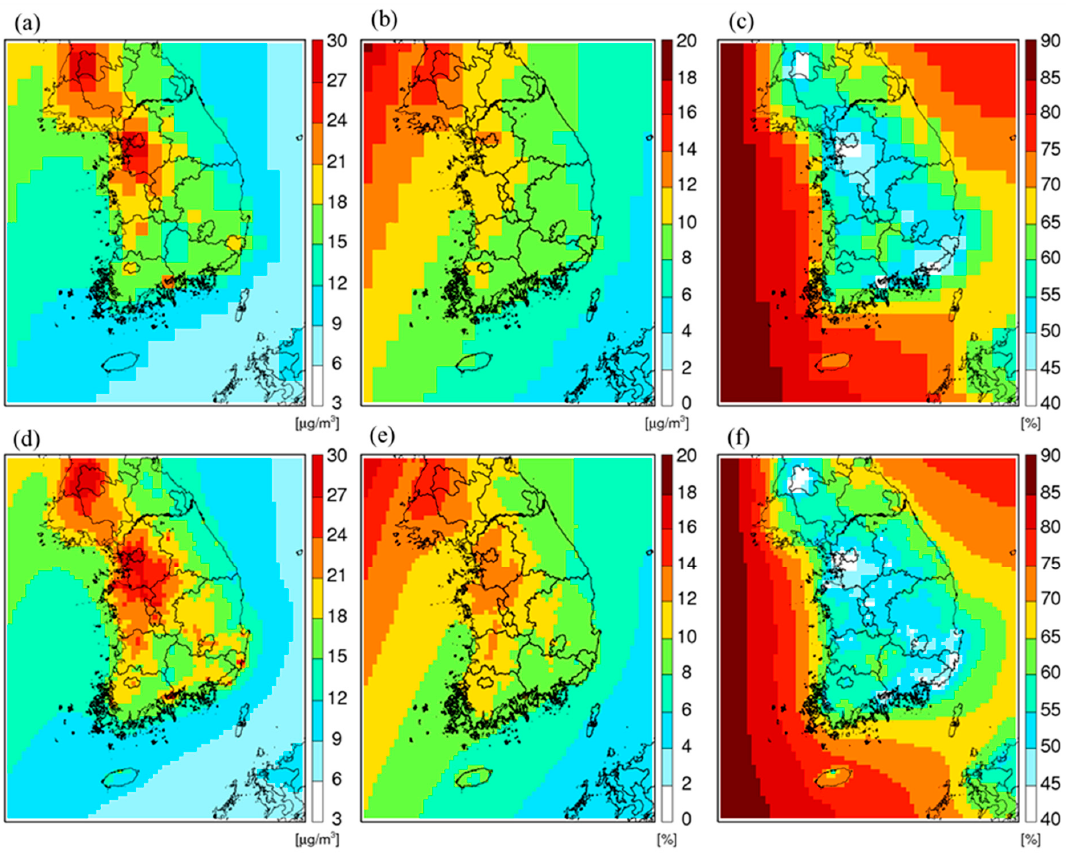
Figure 4. ( a , d ) Period mean PM 2.5 concentrations, ( b , e ) Chinese zero-out contribution (ZOCs), and ( c , f )